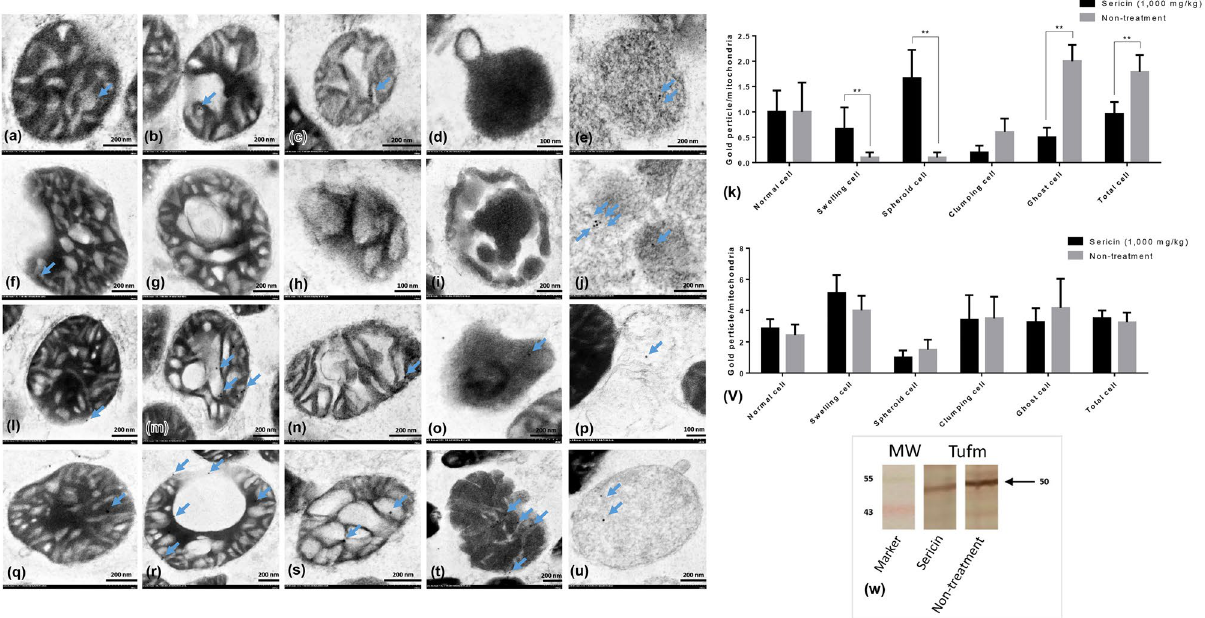
Figure 4. TUFM and LC3 immunogold labelling at each stage of mitochondrial degeneration and Western blot analysis of TUFM. TUFM ( a – k ) and LC3 ( l – v ) gold labelling at all stages of liver mitochondrial degeneration: intact ( a , f , l and q ), swelling ( b , g , m and r ), spheroid ( c , h , n and s ), clumping ( d , i , o and t ) and ghost ( e , j , p and u ). Data in the bar graph is represented by mean ± SEM; **p < 0.01. Western blot analysis of the TUFM level between treated and non-treated rats (w). Full Western blot was provided in the supplementary